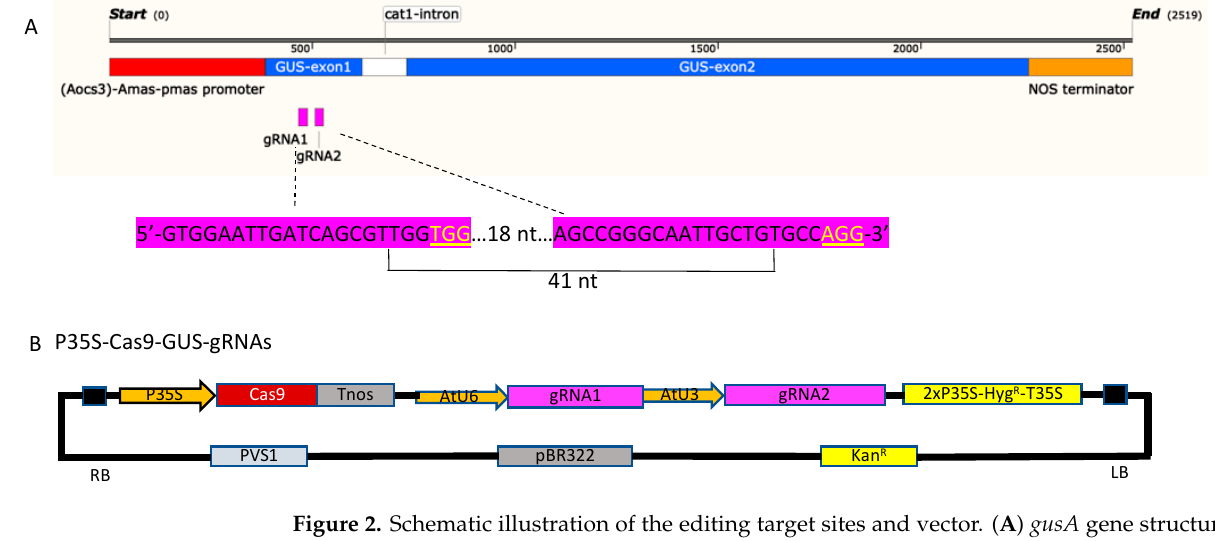
Figure 2. Schematic illustration of the editing target sites and vector. ( A ) gusA gene structure and gRNA target sites and sequences. GUS-gRNA80 and GUS-gRNA140 are marked in pink. The PAM sequences are underlined. ( B ) A schematic diagram of the editing vector. RB, right border; LB, left border; P35S, cauliflower mosaic virus 35S RNA gene promoter; AtU6, A. thaliana small RNA U6 promoter; AtU3, A. thaliana small RNA U3 promoter; T35S, cauliflower mosaic virus 35S terminator; Hyg R , hygromycin resistance gene; pVS1, replication origin from pseudomonas aeruginosa; pBR322, replication origin from pMB1; Kan R , kanamycin resistance